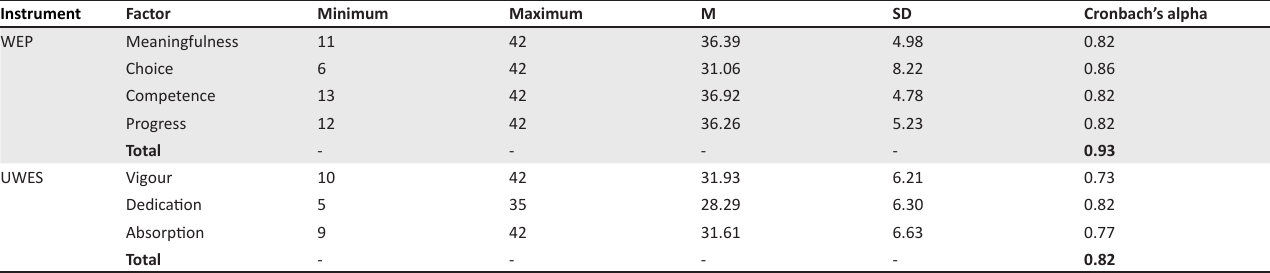
TABLE 2: Descriptive statistics for Work Engagement Profile (WEP) and Utrecht Work Engagement Scale (UWES).